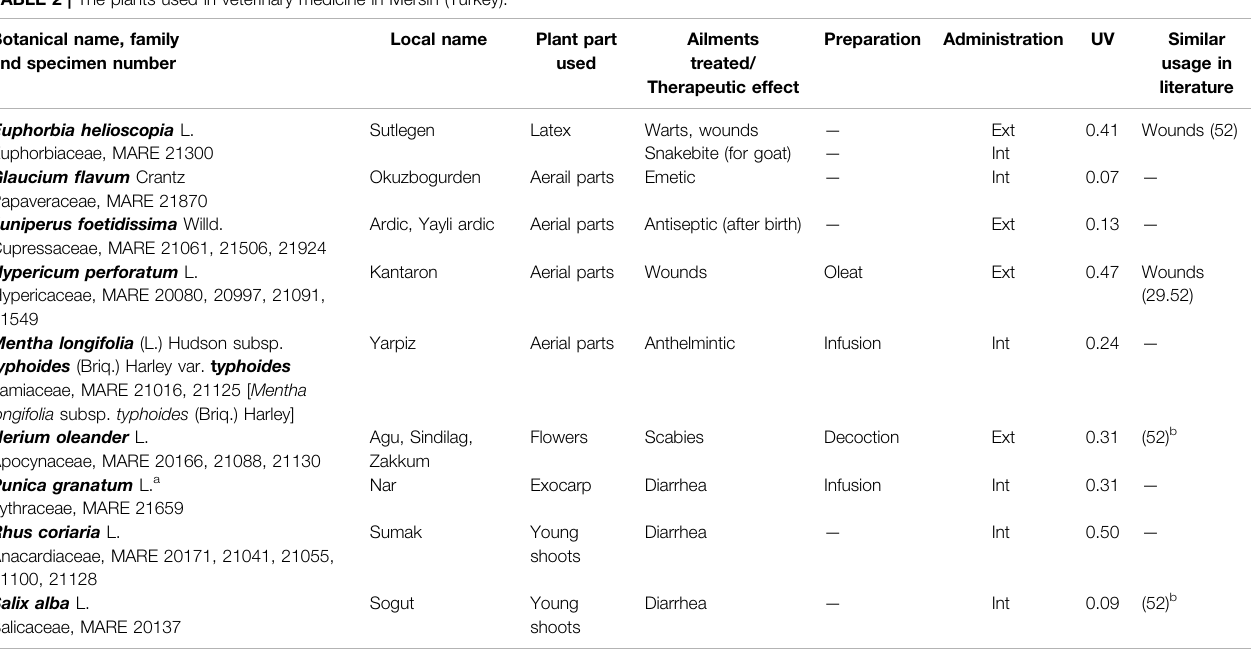
TABLE 2 | The plants used in veterinary medicine in Mersin